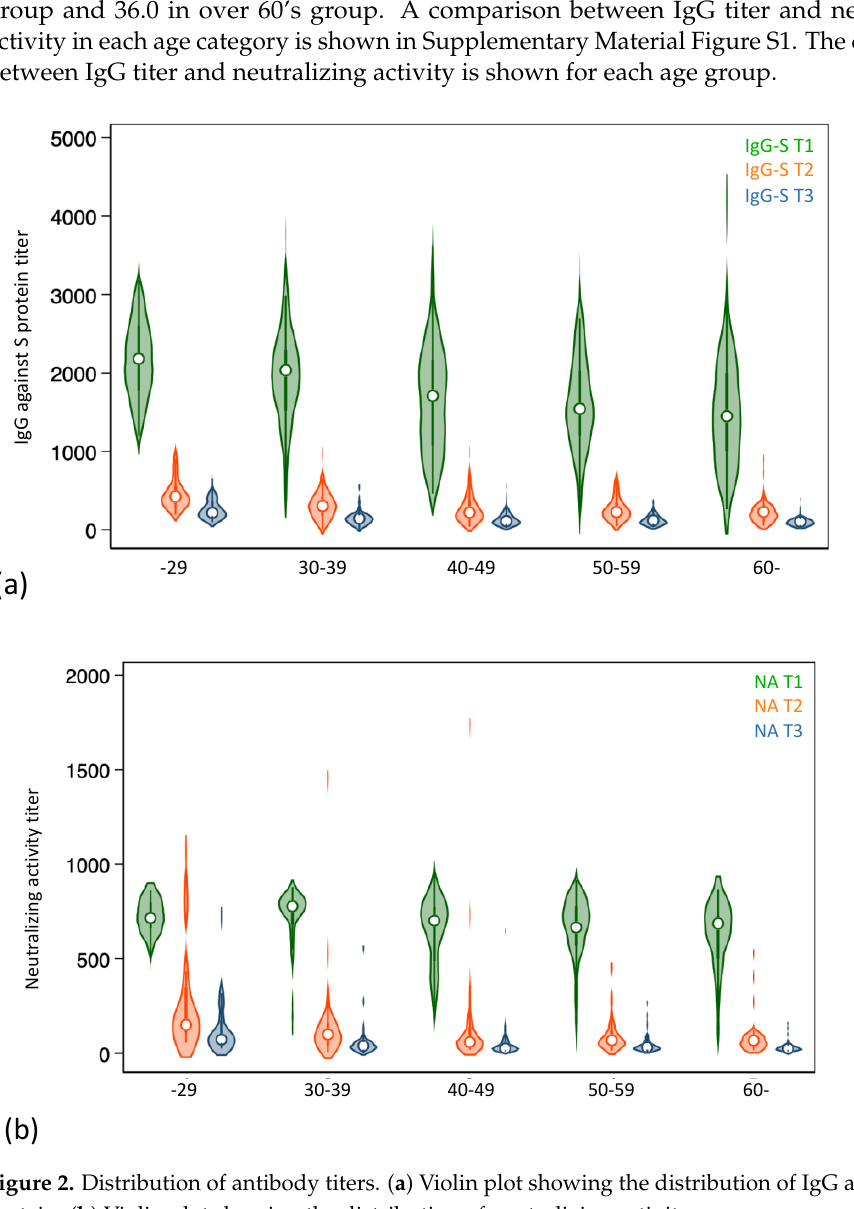
Figure 2. Distribution of antibody titers. ( a ) Violin plot showing the distribution of IgG against the S protein. ( b ) Violin plot showing the distribution of neutralizing activity. The common log-transformed IgG levels against the S protein and the neutralizing activity are shown in Figure 3. The mean interval was 108 and 80 days between T1 – T2 and T2 – T3, respectively; thus, the proportion of interval days between the tests was not equal (T1 – T2:T2 – T3 = 1:0.74). The log-transformed titers also tended to markedly decrease.